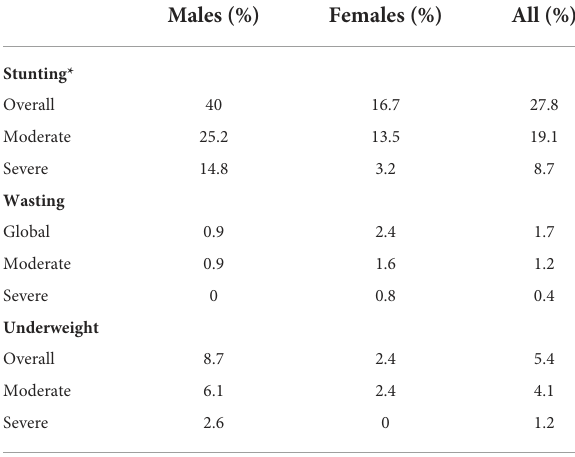
TABLE 4 Distribution of children by their nutritional status ( n =